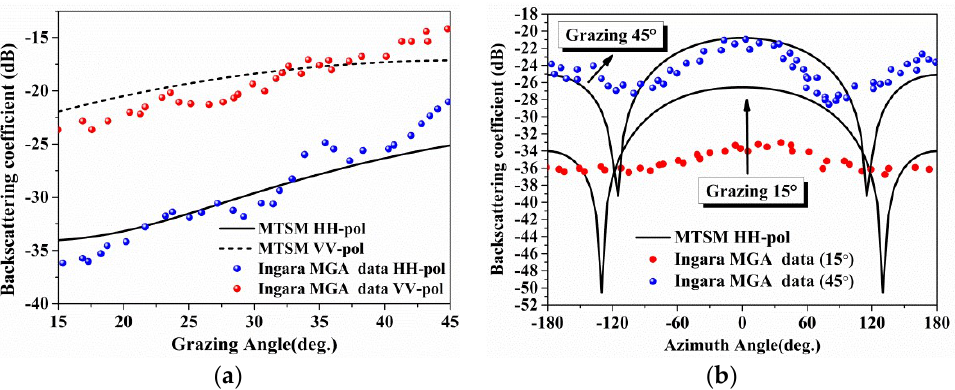
Figure 9. The figures show the variation of the backscattering coefficients with azimuth angle and grazing angle for MTSM Model and Ingara MGA data: ( a ) Grazing angles data and MTSM model prediction; ( b ) Azimuth angles data and MTSM model